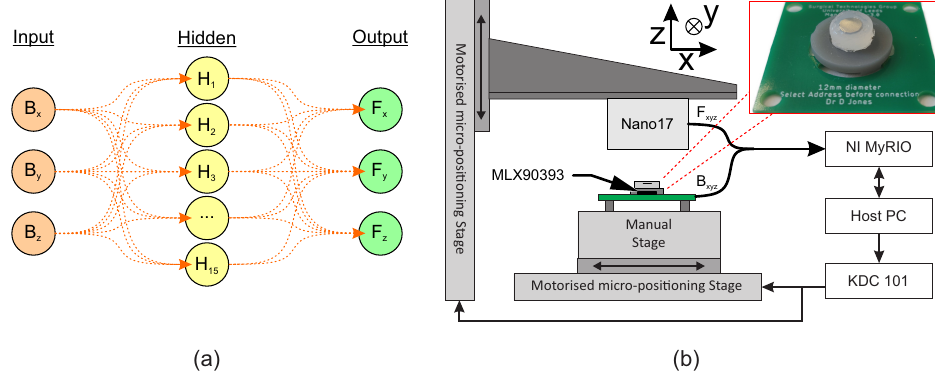
Figure 7. ( a ) Structure of the two-layer neural network used in the calibration; and ( b ) The multi-axis loading test setup , indicating two of the three linear stages used in the calibration. A third stage acts into the plane of the diagram to provide y-axis movement. A real-time measurement device is used to record magnetic field, applied force, and encoded position of the indentor. Inset: The prototype sensor used in calibration with 4 mm magnet embedded.